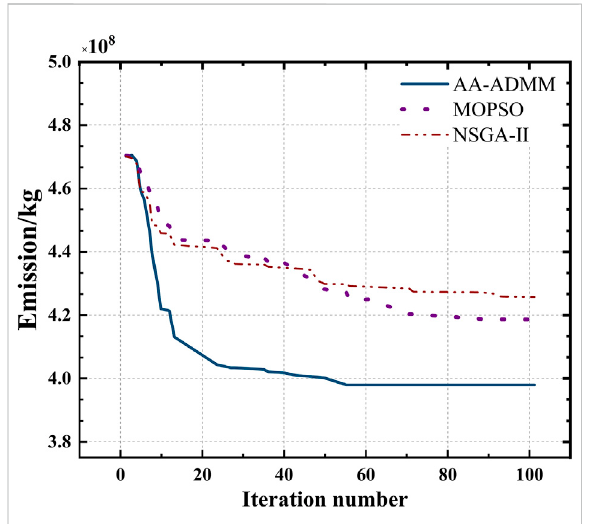
FIGURE 12 Iterative process of the three optimization